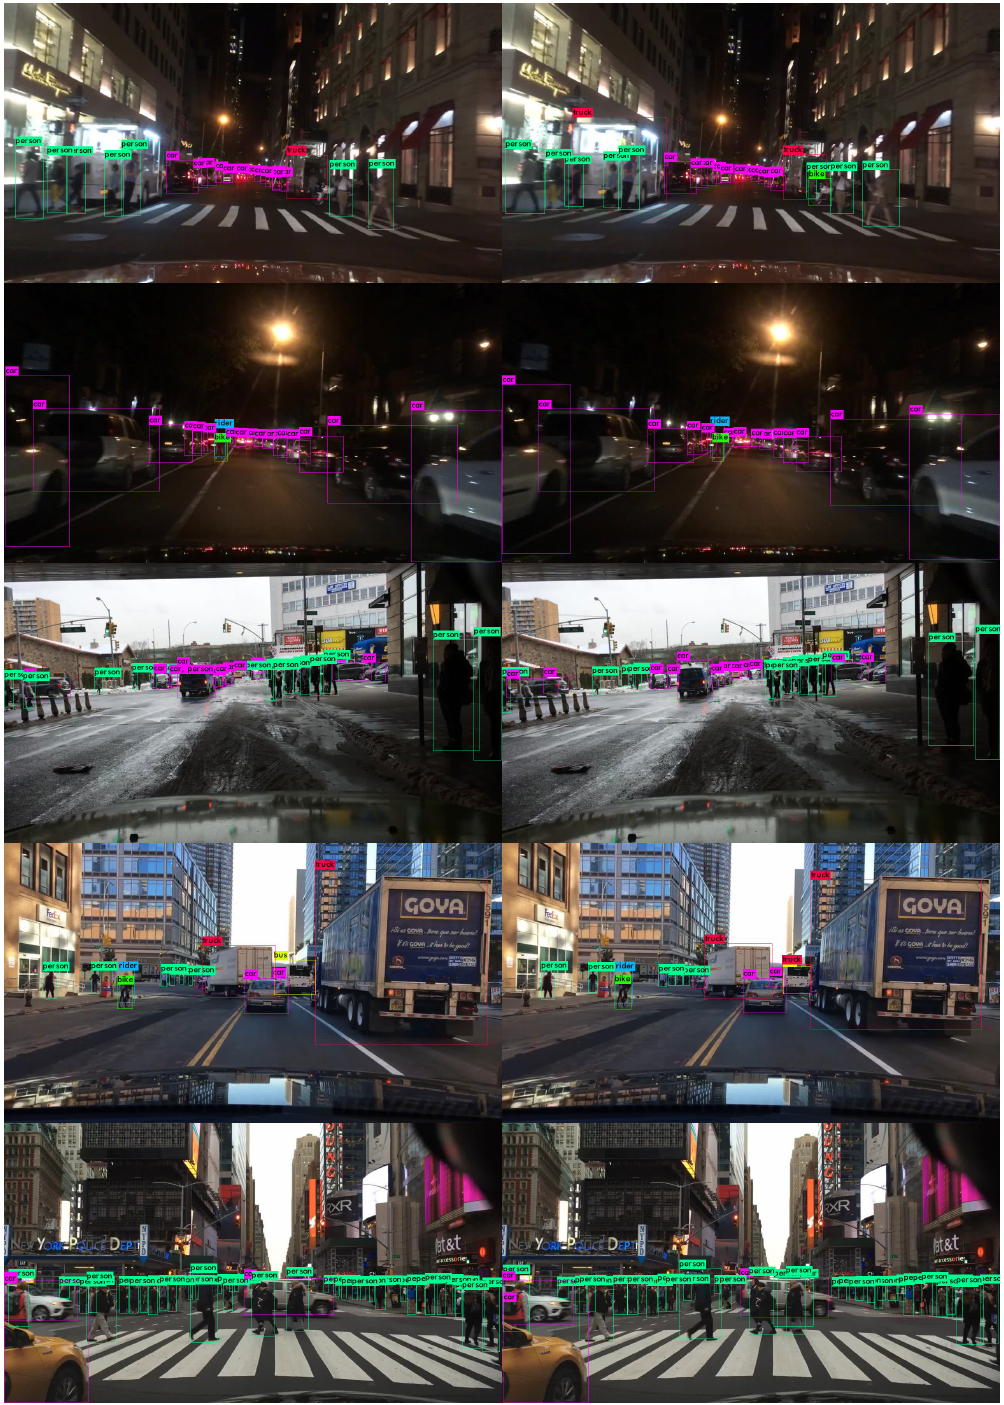
Figure 3. Some processed images from BDD100K test dataset with BDD100K trained models: YOLOv3-416 ( left column) versus YOLOv4-416 ( right